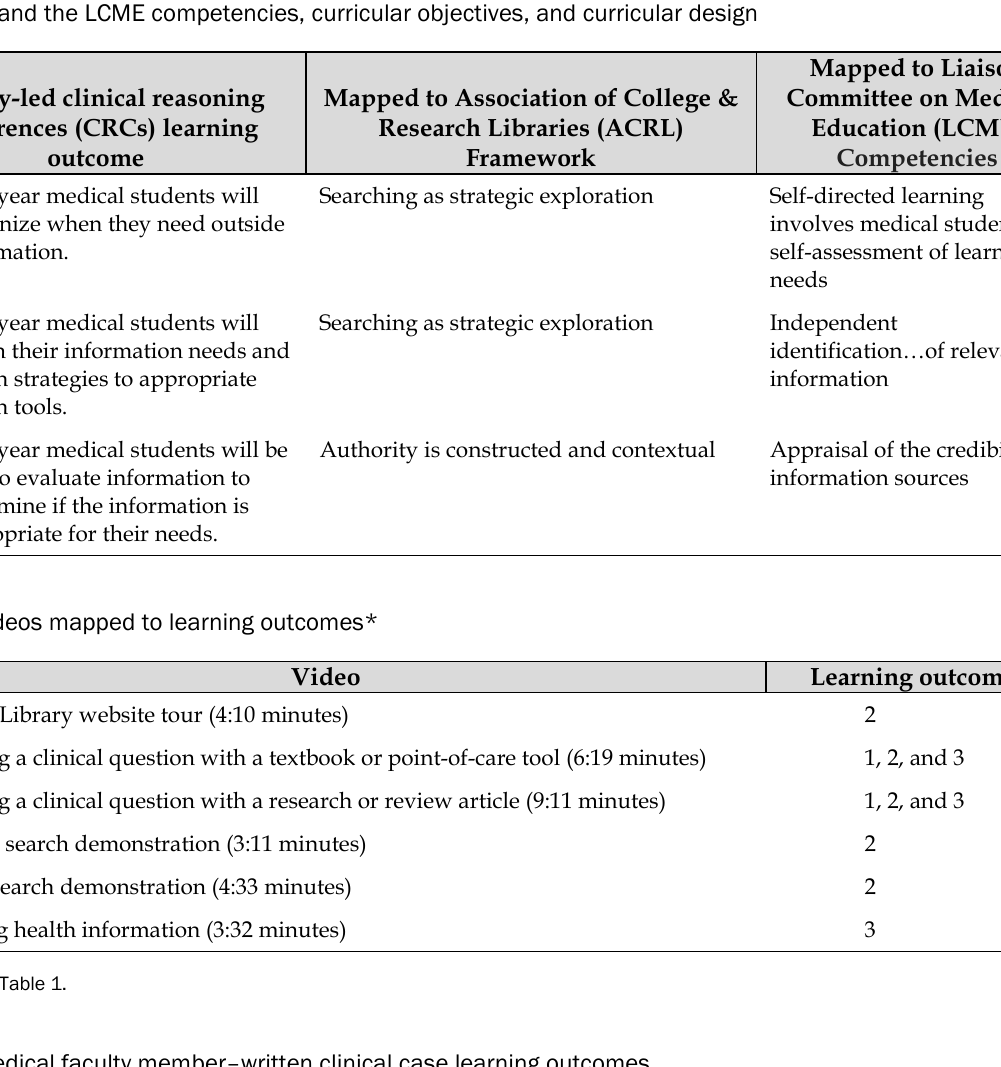
Table 1 Librarian-written learning outcomes mapped to the ACRL Framework for Information Literacy in Higher Education and the LCME competencies, curricular objectives, and curricular design Library-led clinical reasoning